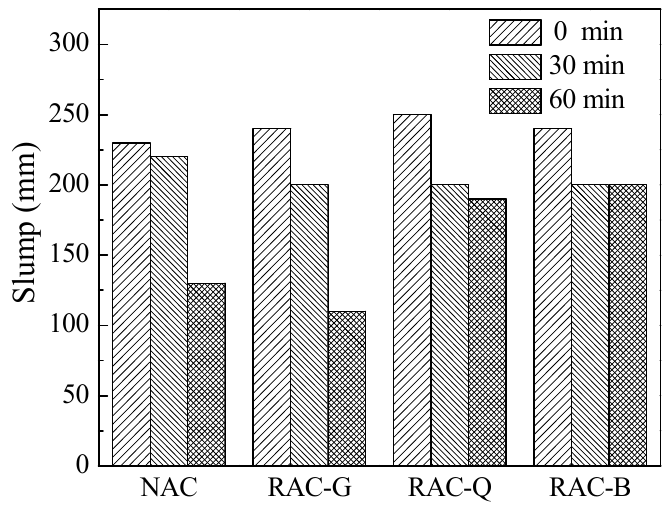
Figure 2. Slump of fresh concrete with different coarse aggregate.